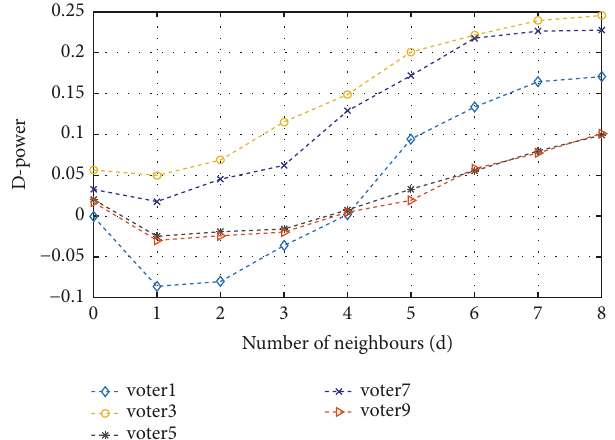
Figure 8: Impact of social network structure on the power index. VotersinthesocialnetworkshowninFigure4playarepeatedvoting game with the number of voter 𝑖 ’s neighbors 𝑑 𝑖 increasing from 𝑑 𝑖 = 0 to 𝑑 = 8 while keeping the other parameters. While the integrated 𝑖 power index may decrease when the number of neighbors changes from0to1,thechangesinpowerindices( 𝐷 - 𝑝𝑜𝑤𝑒𝑟(𝑖) = 𝑅 󸀠 (𝑖)−𝐵 󸀠 (𝑖) ) increase with the number of neighbors increasing from 1 to